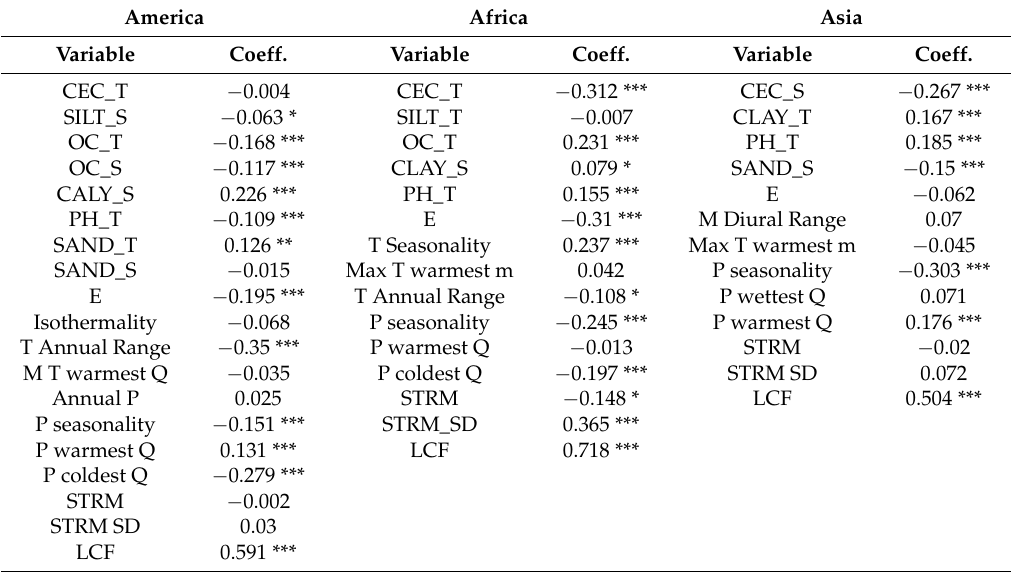
Table 2. Spatial regression results using SEVM method for TCH m .